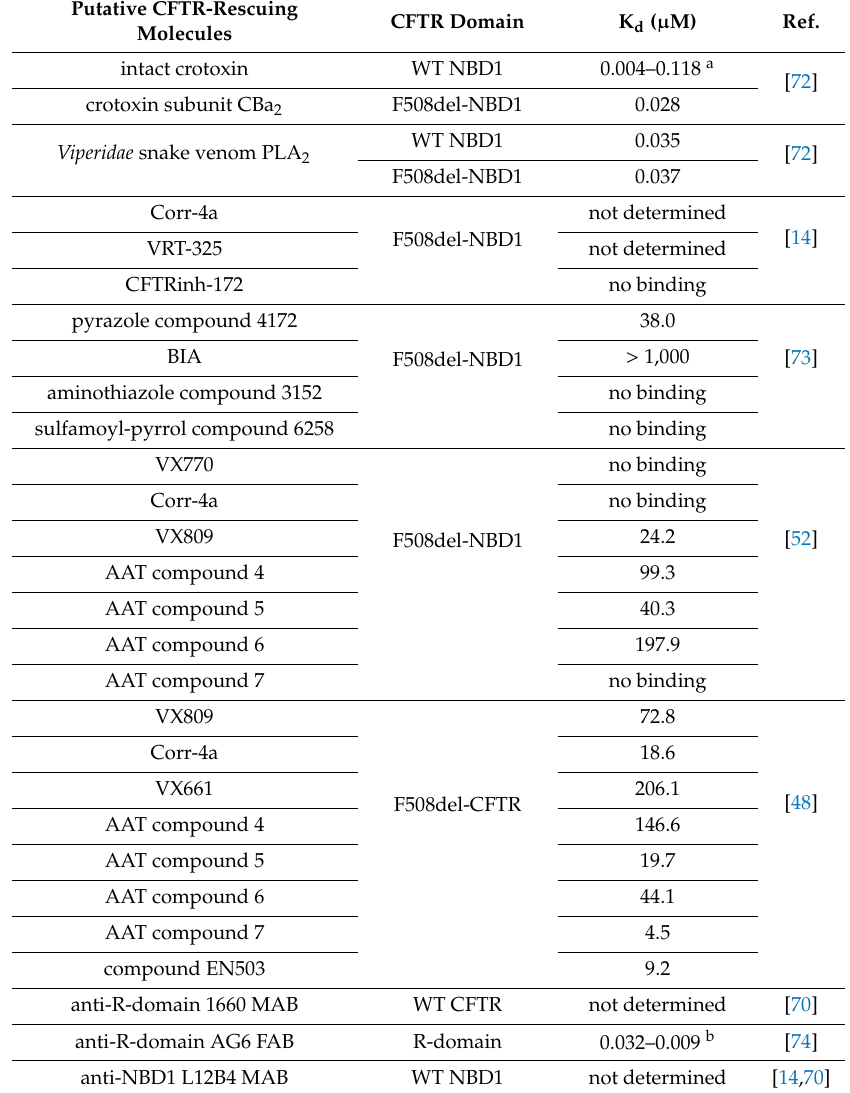
Table 4. List of natural or synthetic binders evaluated by SPR for their capacity to interact with CFTR. Putative CFTR-Rescuing